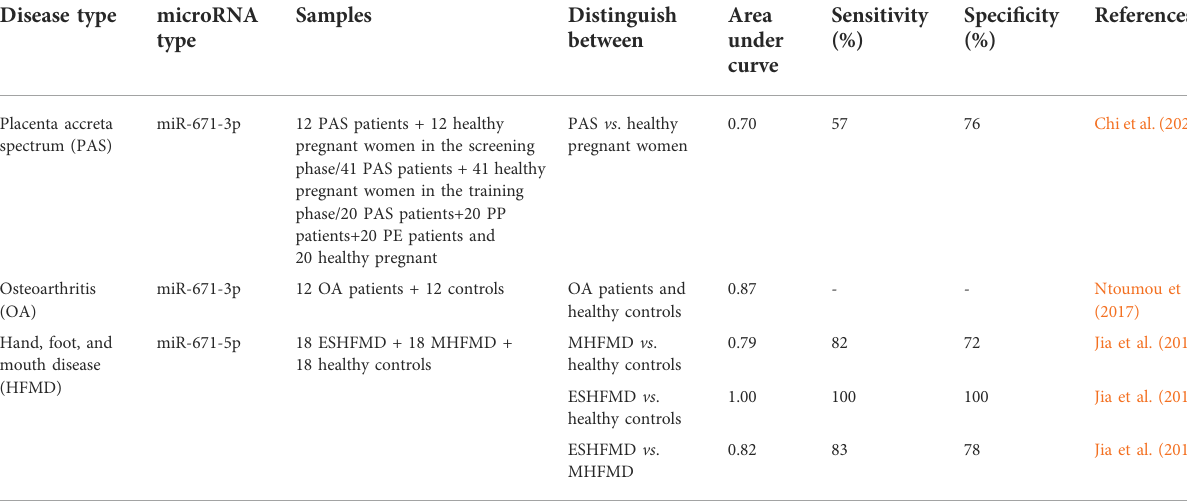
TABLE 7 Diagnostic value of miR-671 in diseases (Mild HFMD: MHFMD, extremely severe HFMD: ESHFMD). Disease